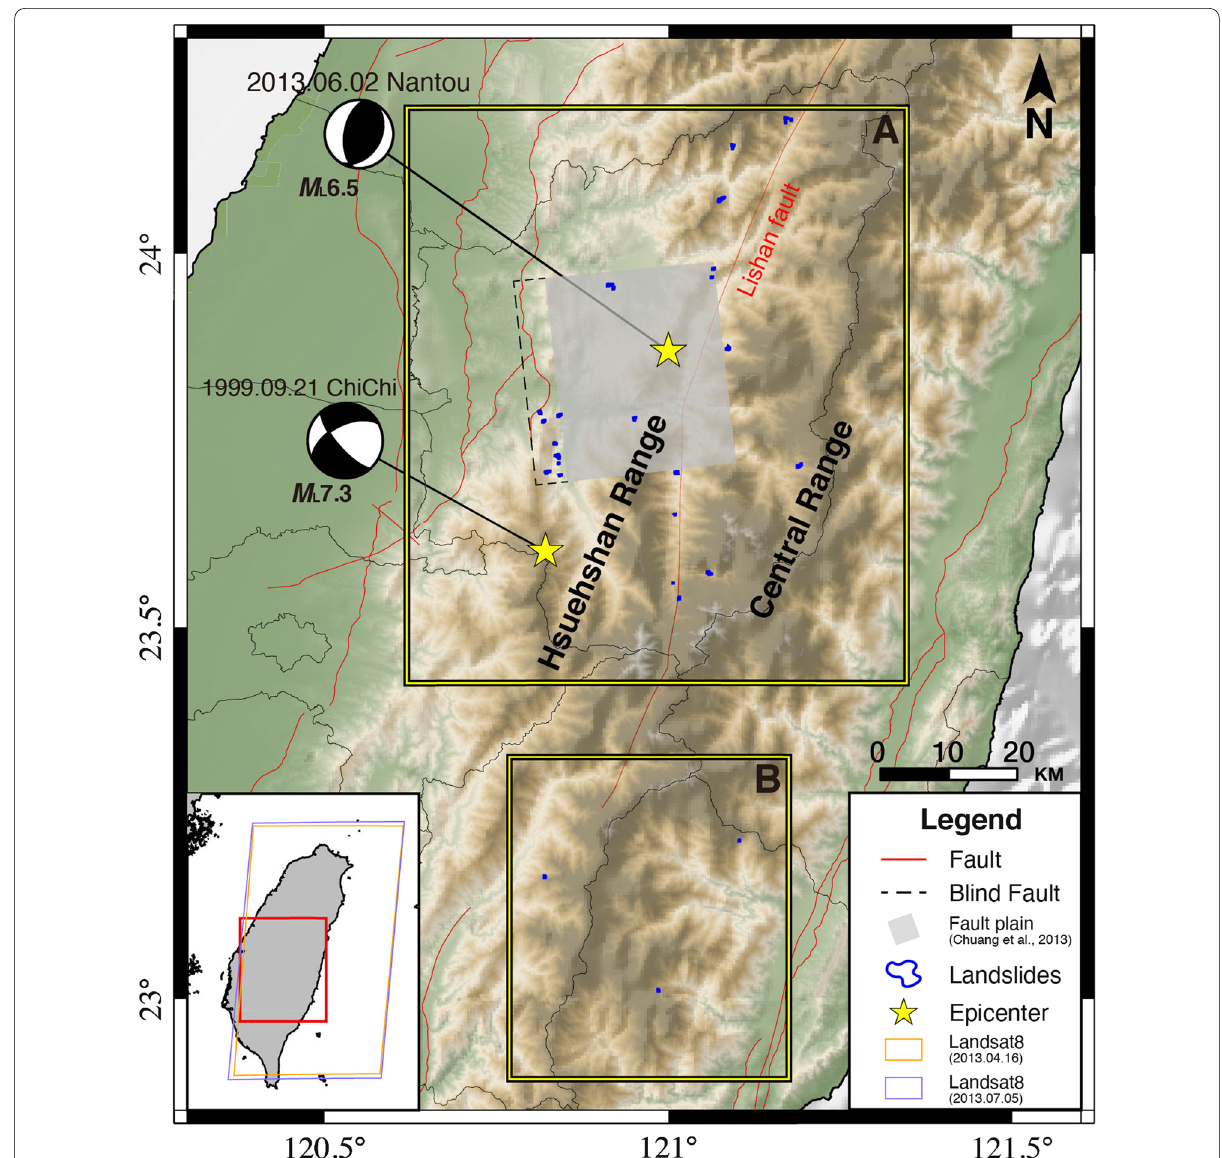
Fig. 1 Landslide areas for the 2013 M L 6.5 Nantou earthquake. Square A : the main extent of landslides. Square B : landslides might be triggered by the